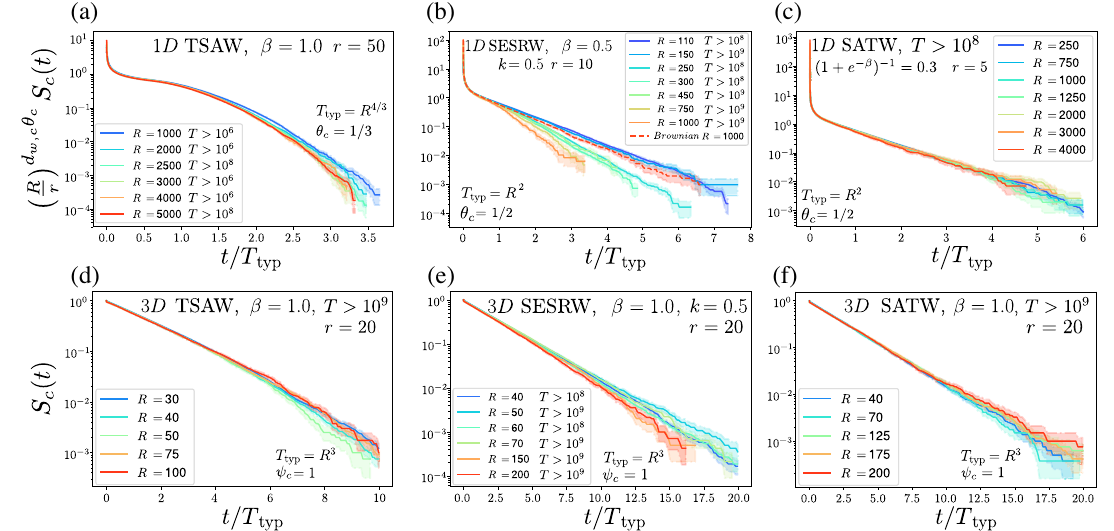
FIG. 7. Asymptotic FPT distribution of self-interacting random walks in confined domains for aged initial conditions. The search process starts at t ¼ 0 , but the random walker is assumed to have explored the domain from t ¼ − T to t ¼ 0 . Here, S ð t Þ is the survival probability of the random walker at time t . The scaling of S ð t Þ with geometrical parameters is deduced from Eqs. (32) and (35) for compact and noncompact processes, respectively. The collapse of numerical simulations after rescaling captures the dependence of the FPT distribution on geometrical parameters. Simulations are performed in 1 d and 3 d boxes of size R with reflecting boundary conditions for fixed r and a . Compact cases: (a) 1 d TSAW with β ¼ 1 . 0 ; (b) 1 d SESRW with β ¼ 1 . 0 and k ¼ 0 . 5 [the FPT distribution of the simple random walk is added for comparison (dashed curve)]; (c) 1 d SATW repulsive with β defined in inset. Noncompact cases: (d) 3 d TSAW with β ¼ 1 . 0 ; (e) 3 d SESRW with β ¼ 1 . 0 and k ¼ 0 . 5 ; (f) 3 d SATW with β ¼ 1 . 0